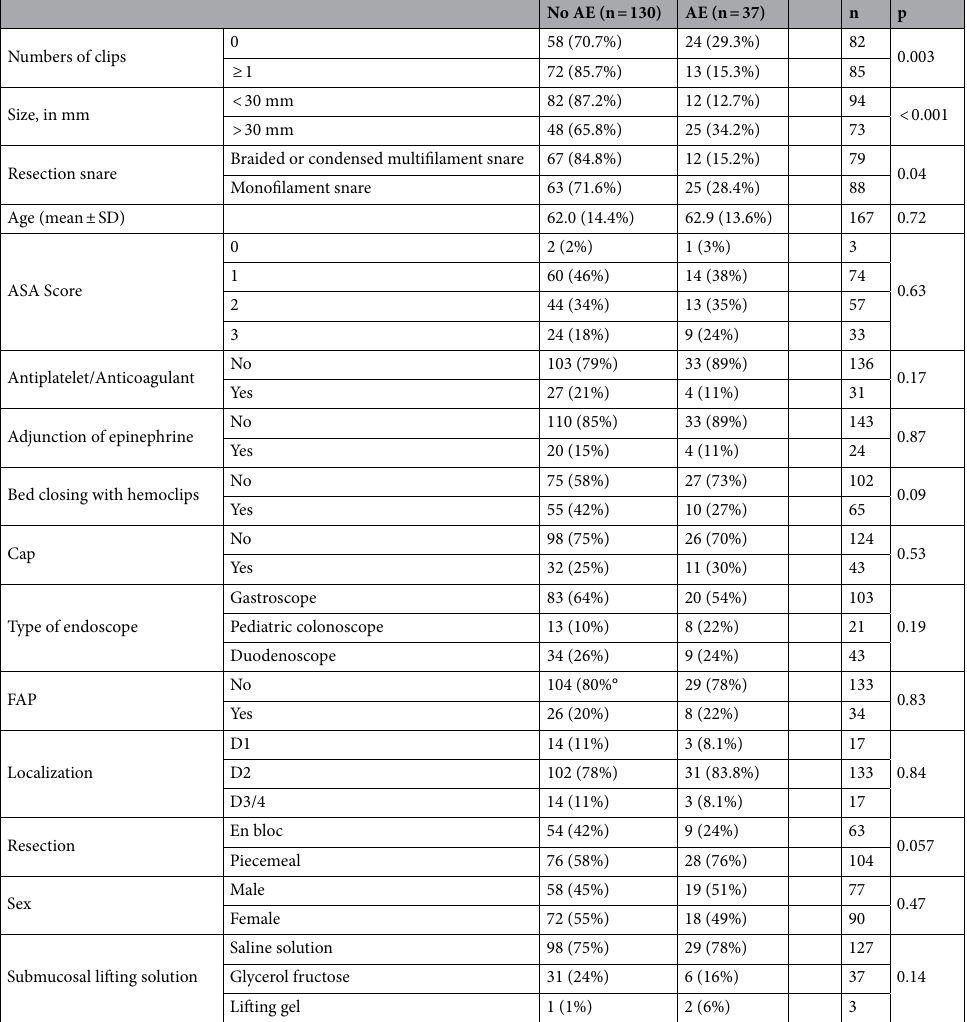
Table 4. Adverse events after endoscopic mucosal resection for duodenal adenomas in univariate analysis. AE: adverse events, n: number; D1: first duodenum; D2: Second duodenum; D3/4: third & fourth duodenum; FAP: familial adenomatous polyposis.